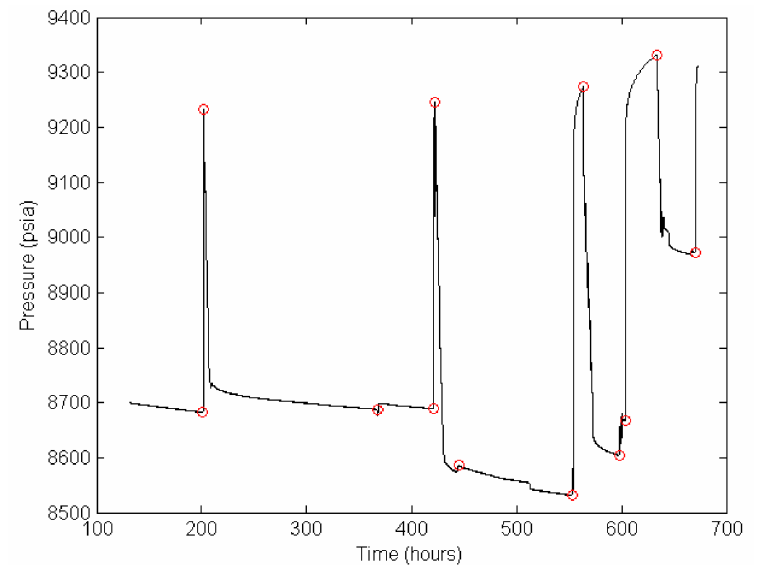
Figure 11. Points with maximum orthogonal distance.